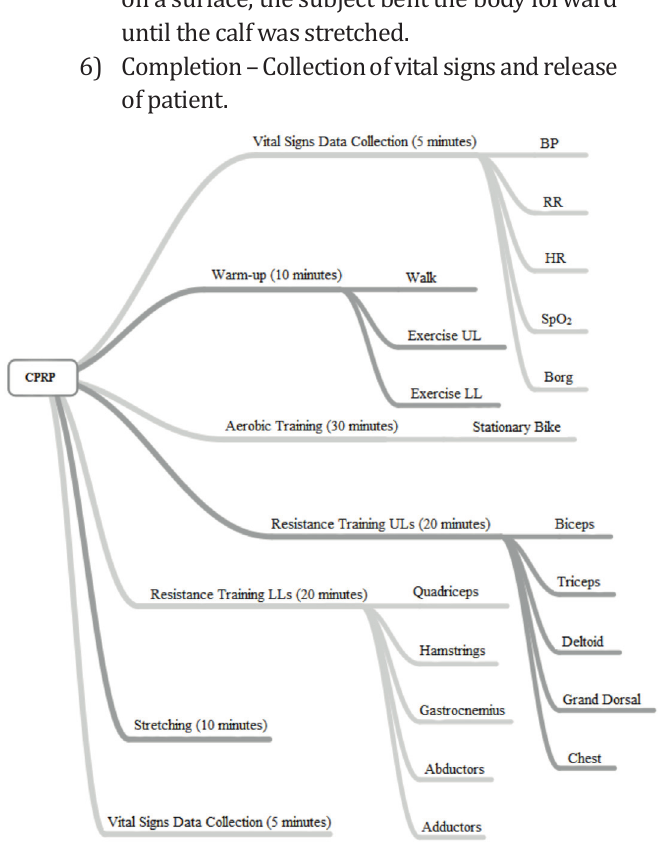
Figure 1 - Organizational chart of the Cardiopulmonary Rehabilitation